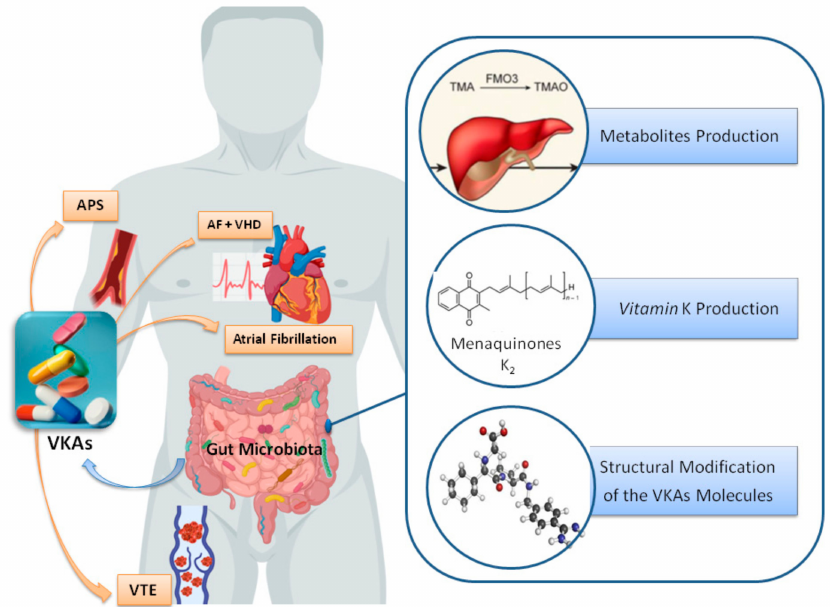
Figure 1. Potential impact of the gut microbiota in vitamin K antagonists. Three hypotheses about the role of the gut microbiota on the quality of anticoagulation in patients taking vitamin K antagonist therapy: (i) Effect of microbial metabolites in the bioavailability of VKAs; (ii) bacterial production of vitamin K and; (iii) structural modification of VKA molecules. Abbreviations: AF, atrial fibrillation; APS, antiphospholipid syndrome; VHD, valvular heart disease; VKAs, vitamin K antagonists, VTE, venous